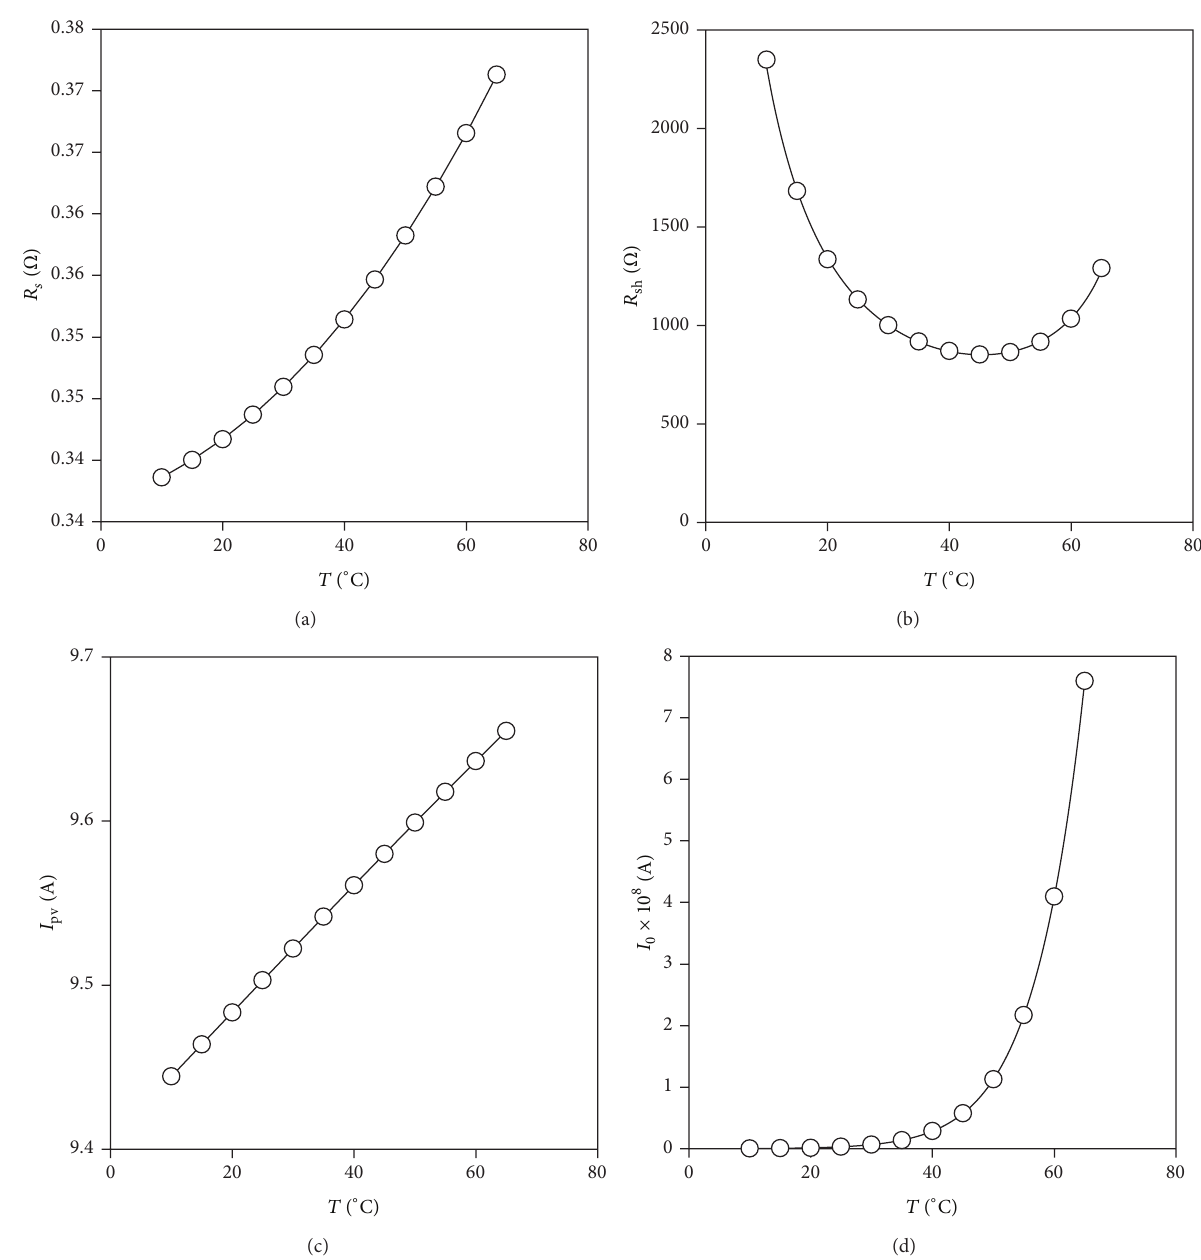
, 𝐼 , and 𝐼 0 , for YL280C-30b monocrystalline panel as a function of sh pv